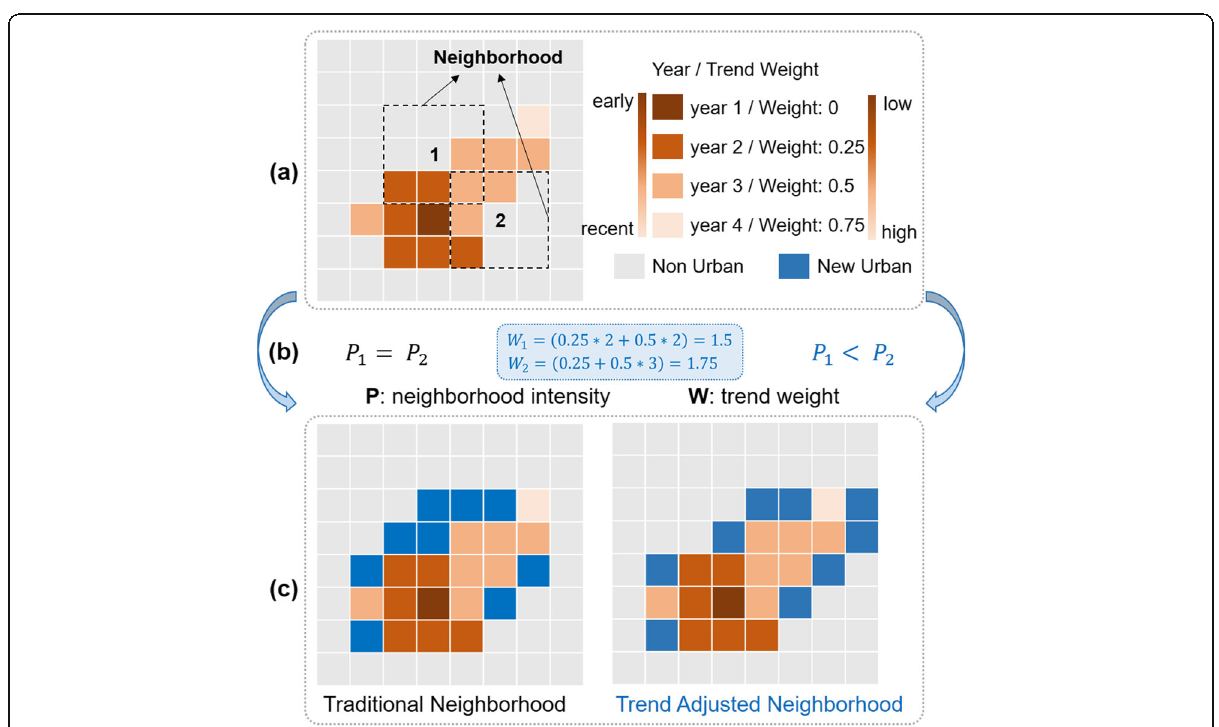
Fig. 4 Illustration of the trend-adjusted neighborhood in the urban CA model. Urban pixels with different developing years and weights (a), calculation of neighborhood impacts for pixels 1 and 2 (b), and modeled urban sprawl using different neighborhoods (c). This illustrative figure shows the results of allocating three urban pixels per iteration, with a total of nine urban pixels. Trend weights in (a) were calculated using Eq. (3) with a temporal span of 4